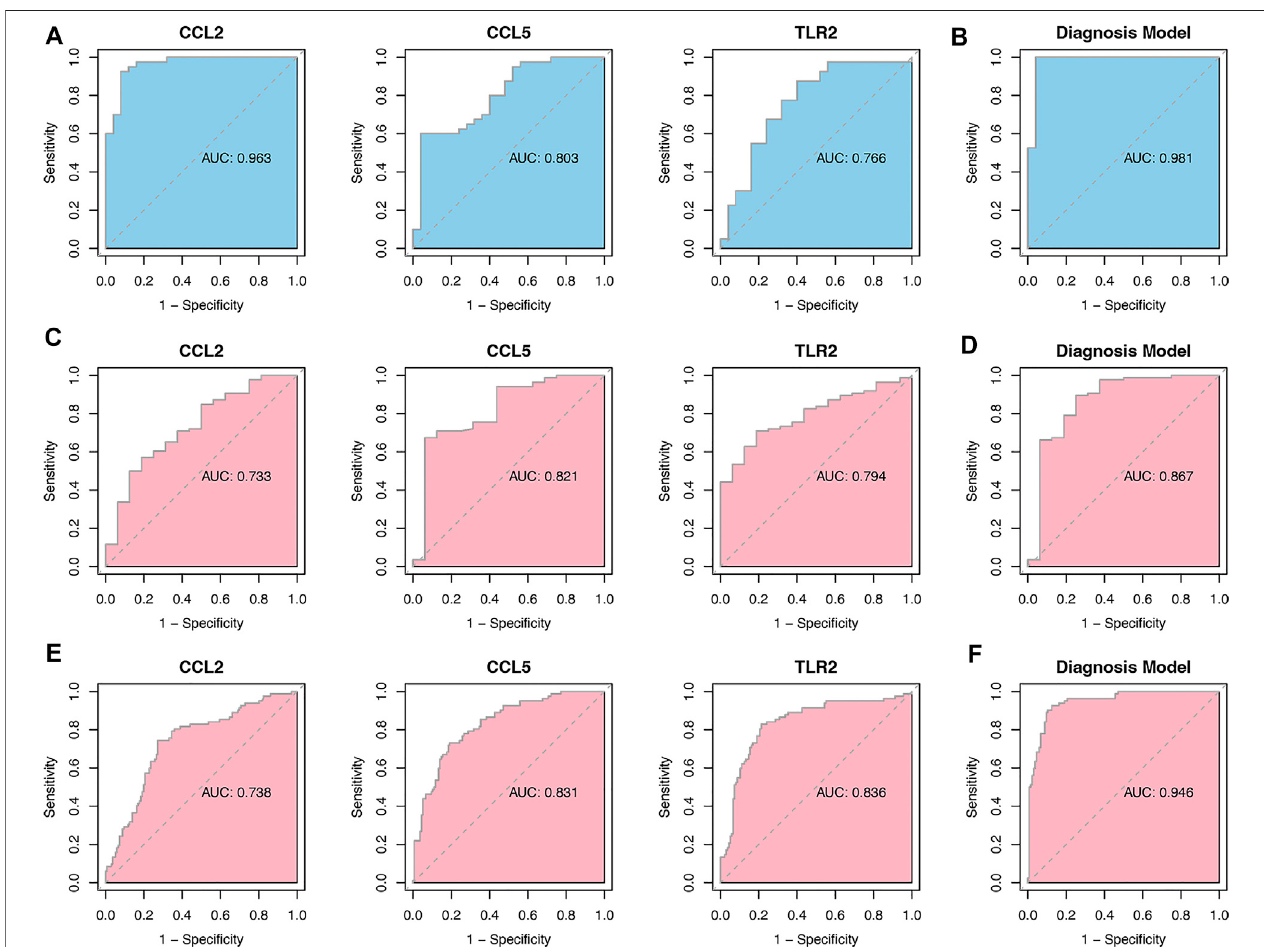
FIGURE 8 | Analysis of the disease predictive abilities of the three selected hub genes (A) ROC curve analysis of three selected hub genes in merged dataset (B) ROCcurveanalysisofdiagnosismodelusing thethreeselectedhubgenesinmerged dataset (C) ROCcurve analysisofthreeselectedhubgenesinGSE5406 (D) ROC curve analysis of diagnosis model using the three selected hub genes in GSE5406 (E) ROC curve analysis of three selected hub genes in GSE57338 (F) ROC curve analysis of diagnosis model using the three selected hub genes in